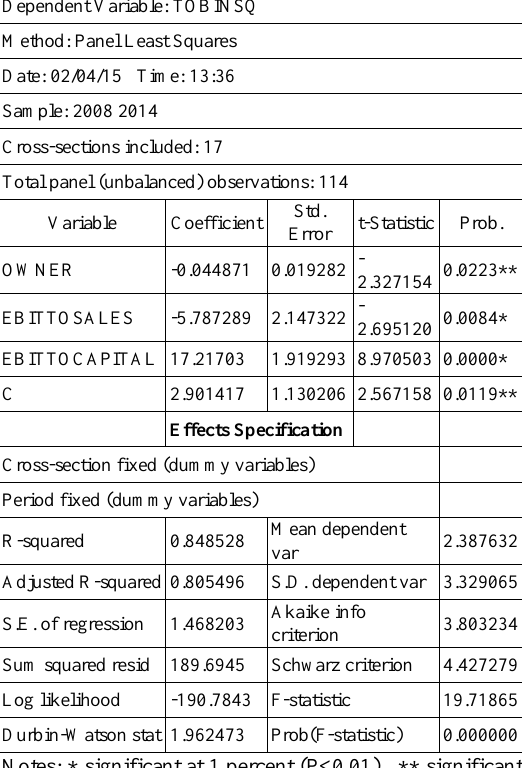
Table 2.Results of Panel Least